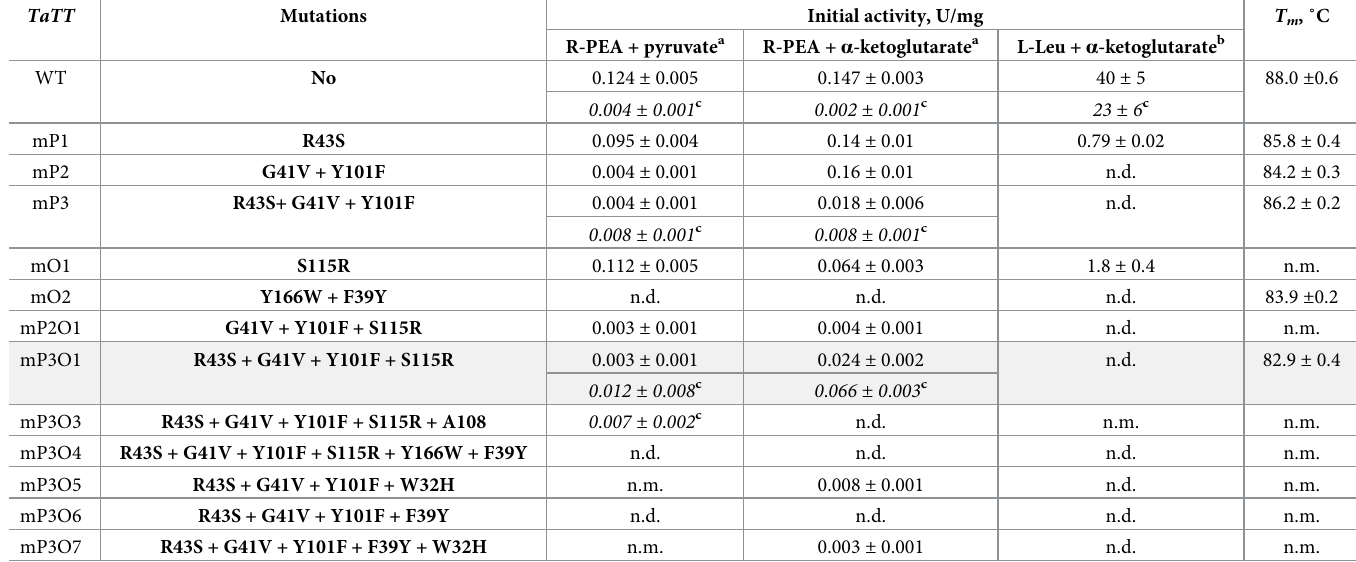
Table 3. TaTT variants and their initial activities in the overall reactions between R-PEA and pyruvate, R-PEA and α -ketoglutarate, L-leucine and α